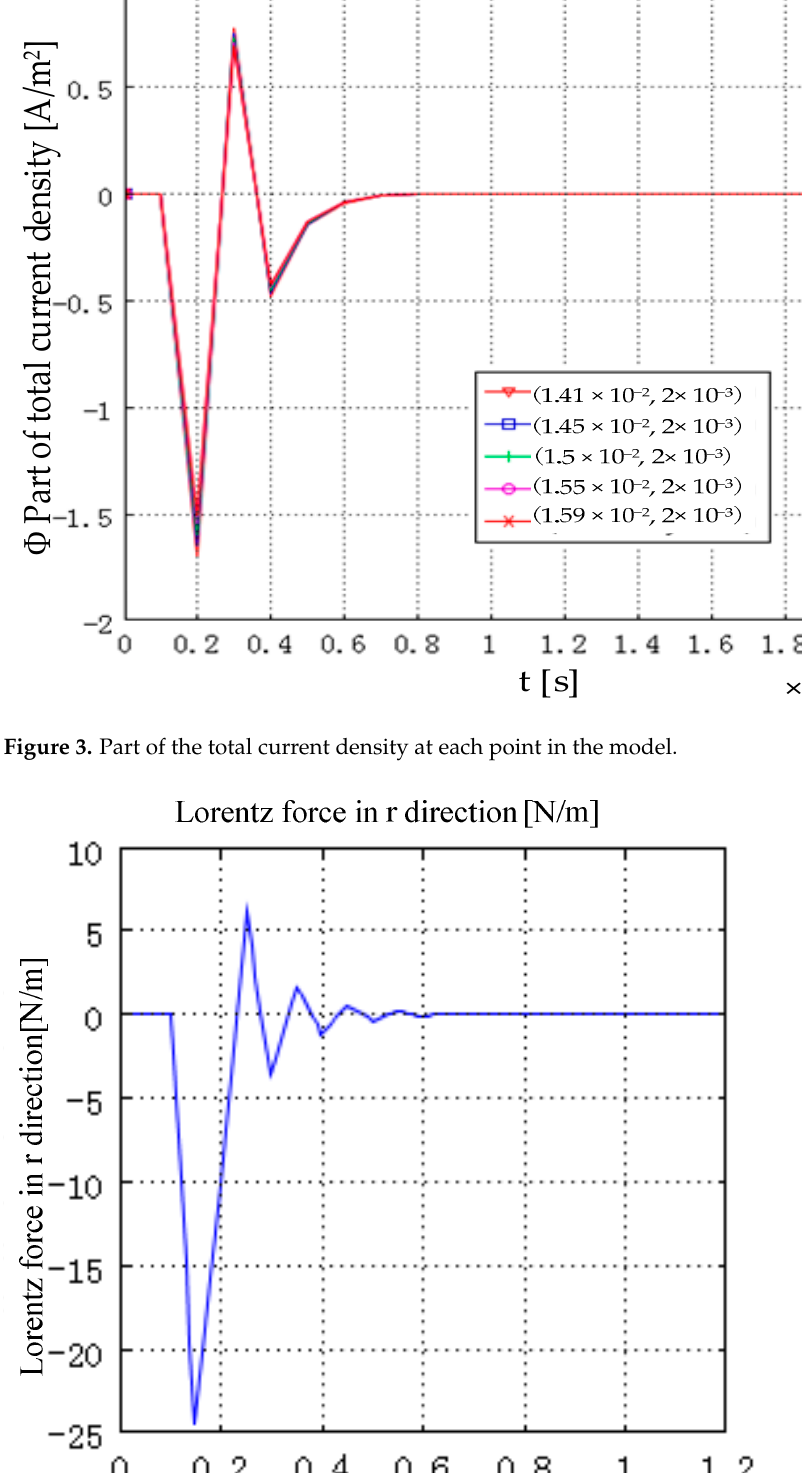
t[s] Figure 5. Lorentz force in z direction .